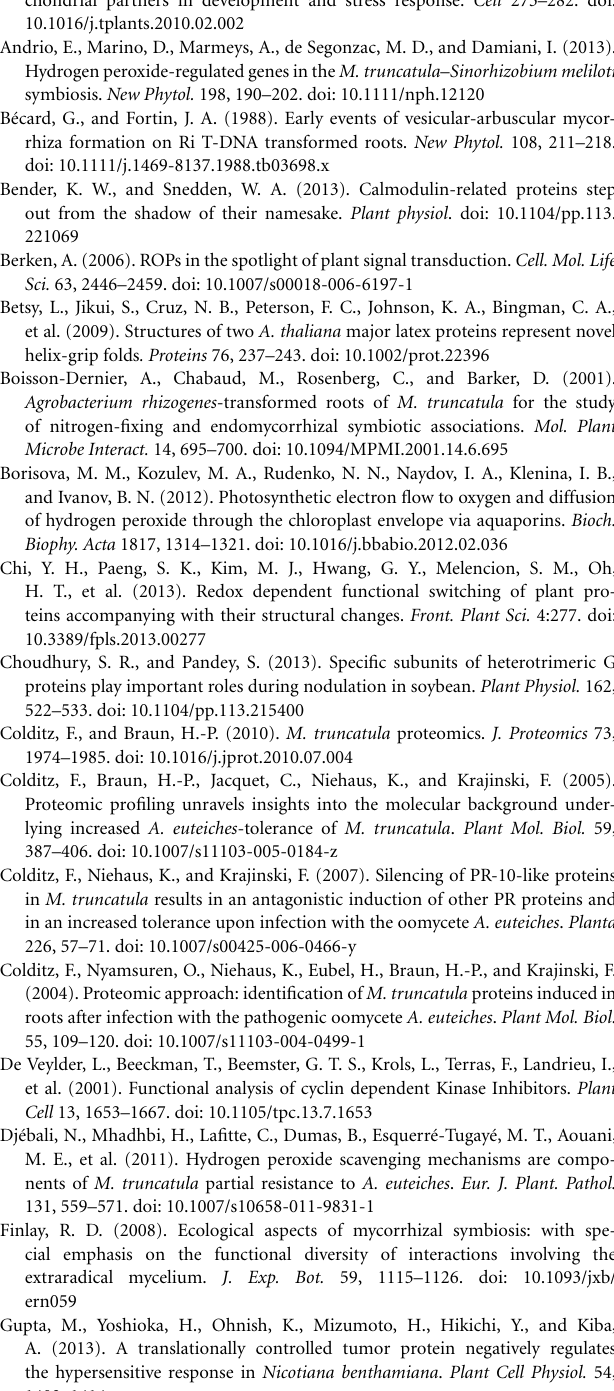
right and the minigraphs for the trend of total induction over 1, 3, 5, and 24hpi is shown at the bottom. Supplementary Figure 2 | Heatmap of total protein regulation in each physiological category over the four time-points for S. meliloti (A), A. euteiches (B) and G. intraradices (C)